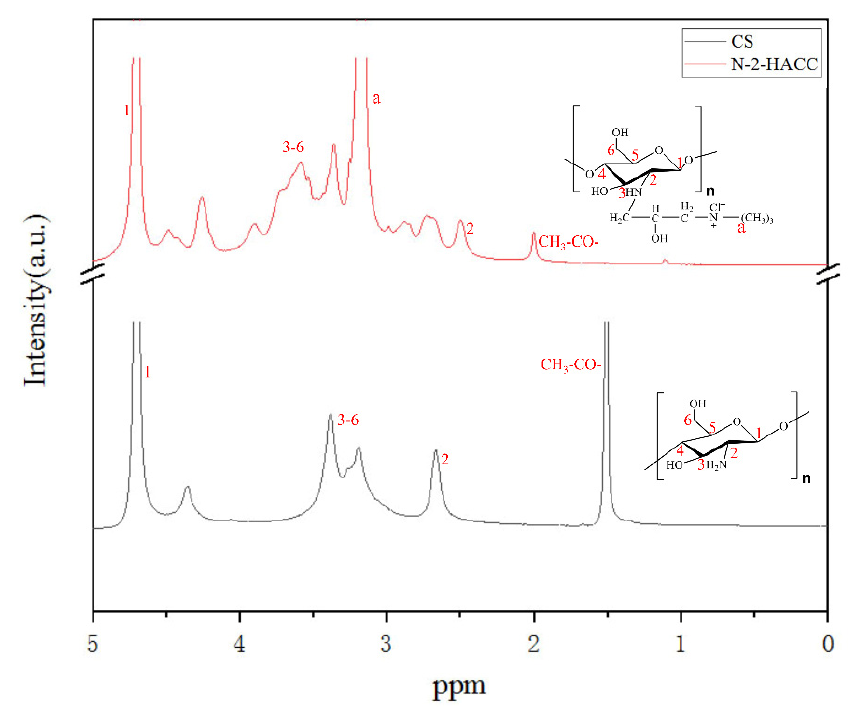
Figure 3. 1 H-NMR spectra of CS and N-2-HACC.